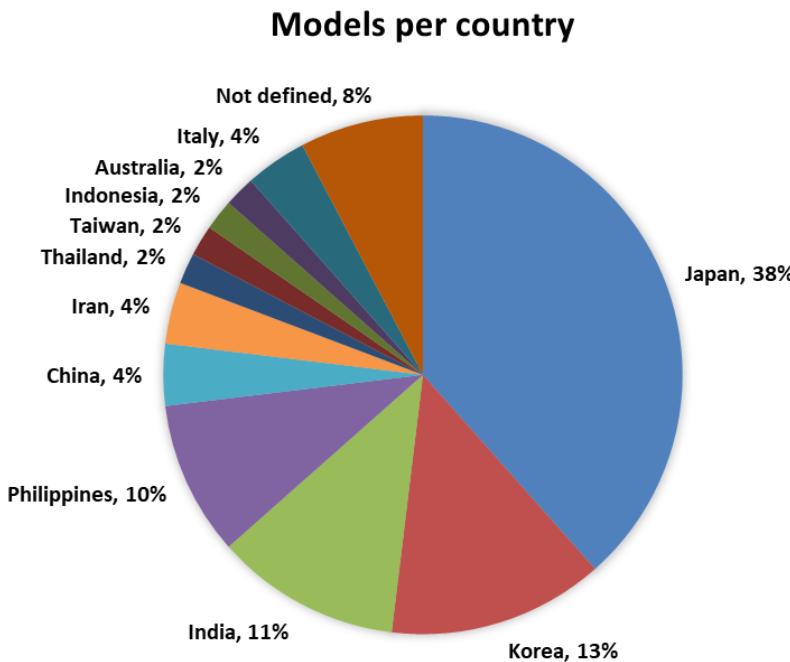
Figure 3. Country distribution of published rice blast prediction models.